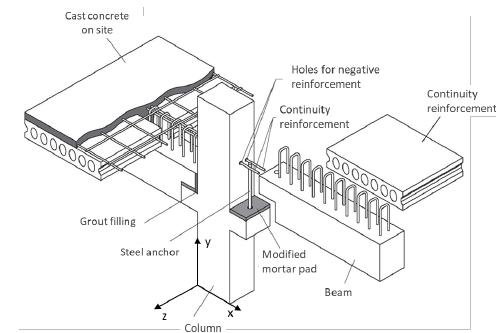
Figure 1. Calibration connection (Adapted from El Debs